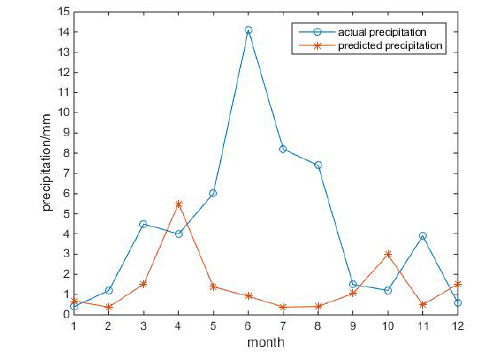
Figure 5. Figure the time series model predicts precipitation changes in 2017